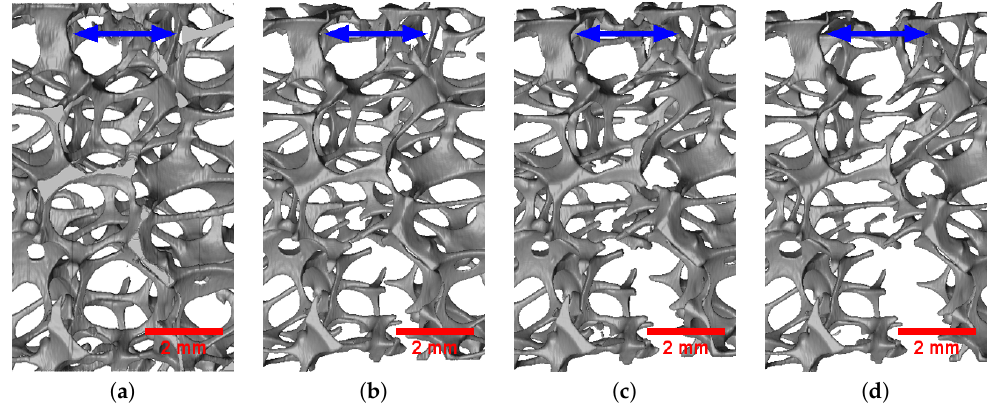
Figure 7. Deformation of the 20 PPI foam sample during the in situ tensile test at nominal strain: